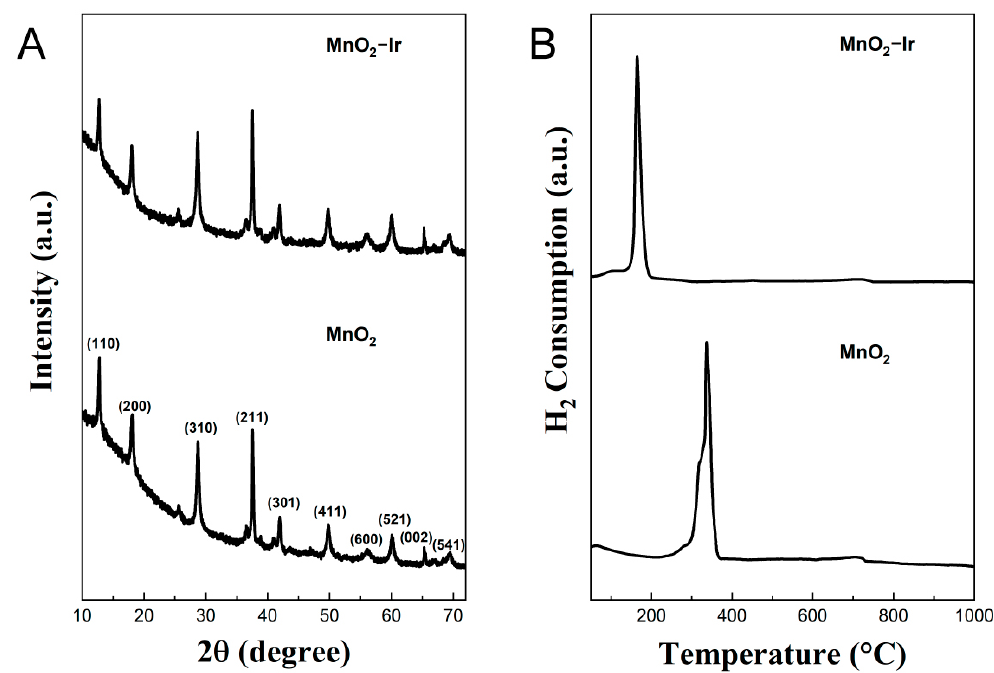
Figure 3. ( A ) XRD patterns and ( B ) TPR profiles of α -MnO 2 nanowires before and after the deposition of ultrasmall Ir NPs.